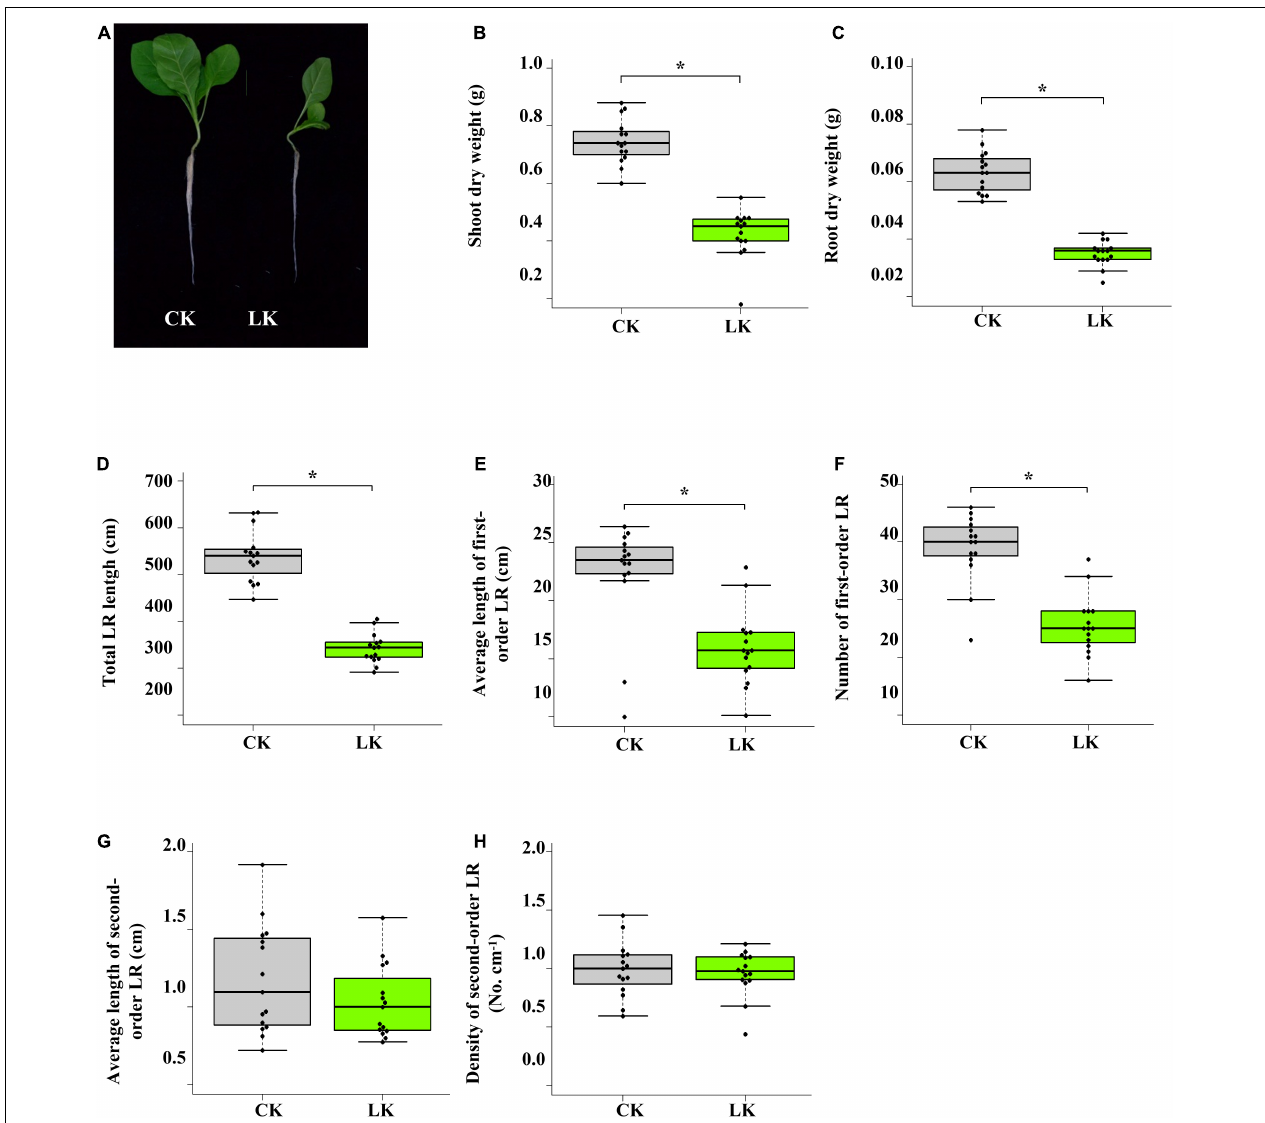
FIGURE 1 | Physiological changes of tobacco seedlings in response to low K + stress. (A) Photographs of tobacco seedlings after 14 days of low K + treatment; (B) Change of shoot biomass in response to low K + stress; (C) Change of root biomass in response to low K + stress. (D–H) Root architecture changes in response to low K + stress. Seedlings were subjected to low K + stress (LK, 0.01 mM) or normal nutrition (Control, 2 mM) for 14 days. LR: lateral root. * p < 0.05 (Student’s t